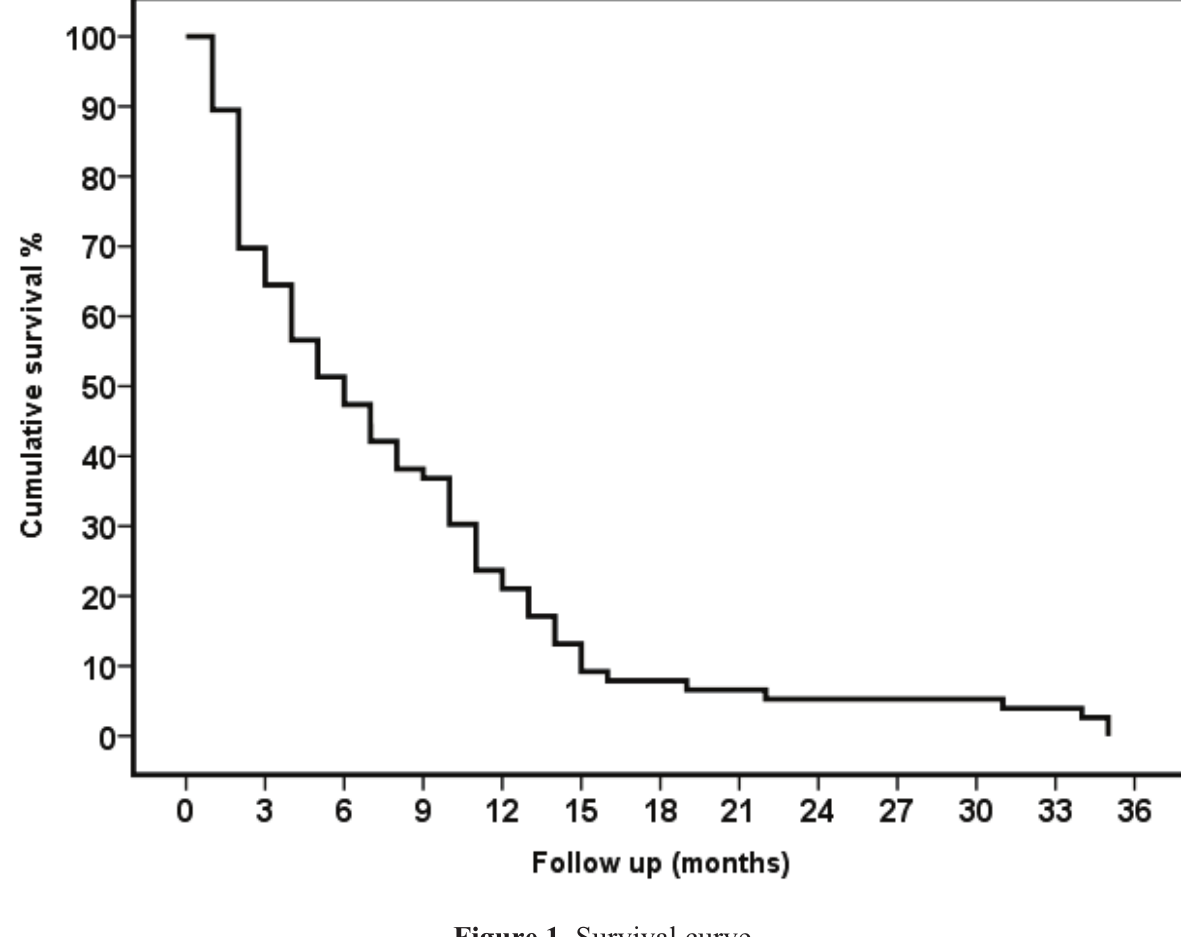
Figure 1. Survival